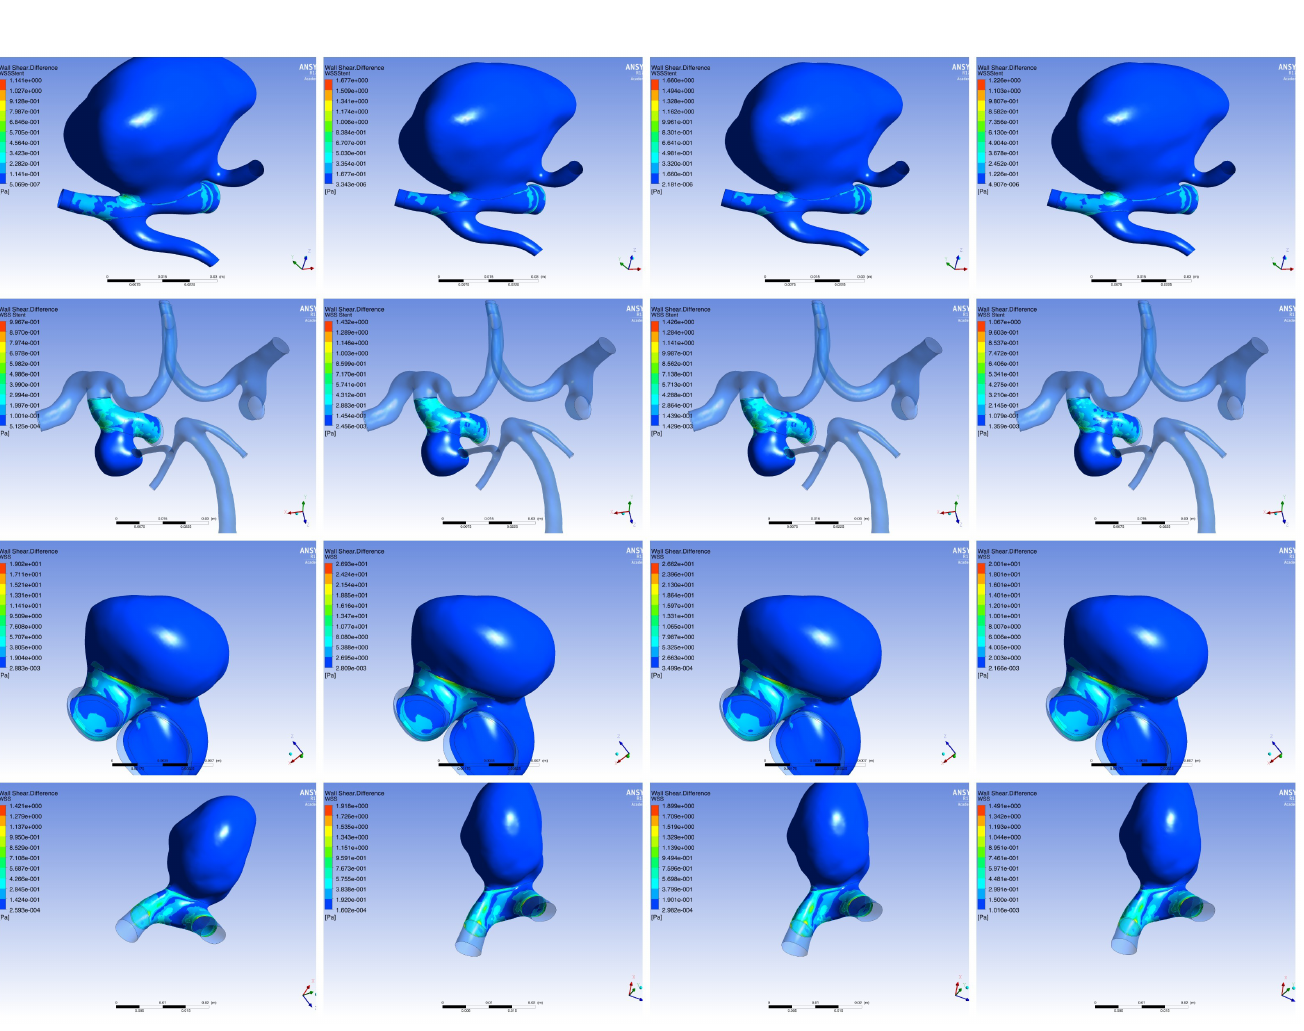
Figure A6. Distribution of ∆ WSS for all patients (number of row corresponds to an identifier of patient) in a non-steady case for time points t 1 – t 4 : Column 1: t 1 , Column 2: t 2 , Column 3: t 3 , Column 4: t 4 . Only Scenario C of stent shape is